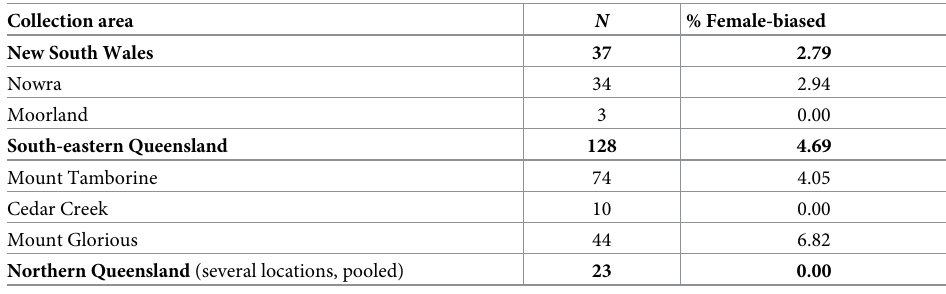
Table 1. Percentage of female-biased lines in the isofemale lines set up from field populations of D . pseudotakahashii